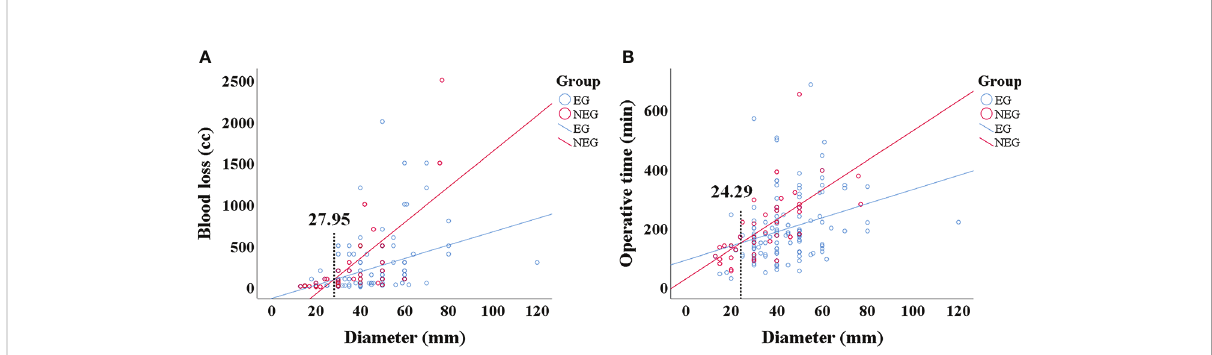
FIGURE 3 (A, B) The correlation between BL, OT, and tumor size. (A) A correlation was established between tumor size and intraoperative BL in those who underwent preoperative embolization (EG) (R = 0.30) and patients who did not (NEG) (R = 0.70), respectively. The intersection point of the two correlation lines was the tumor diameter of 27.95 mm. (B) A signi fi cant correlation was established between the tumor size and intraoperative operative time in EG patients (R = 0.32) and NEG (R = 0.66), respectively. The intersection point of the two correlation lines was the tumor diameter of 24.29